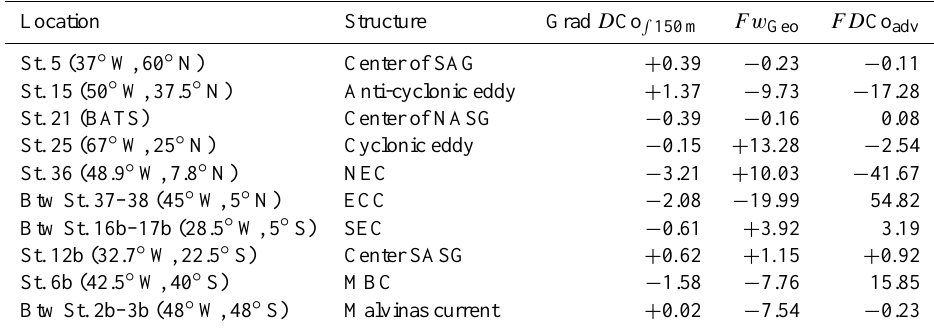
Table 4. Lateral gradient of dissolved cobalt (Grad D Co ∫ 150m ; 10 − 5 nmolm − 3 m − 1 ) , and lateral advective fluxes of dissolved cobalt ( FD Co adv ; nmolm − 2 d − 1 ) generated by local geostrophic lateral advection ( Fw Geo ; cms − 1 ) are given in the upper 150m for several sampling stations corresponding to key dynamical structures or domains.